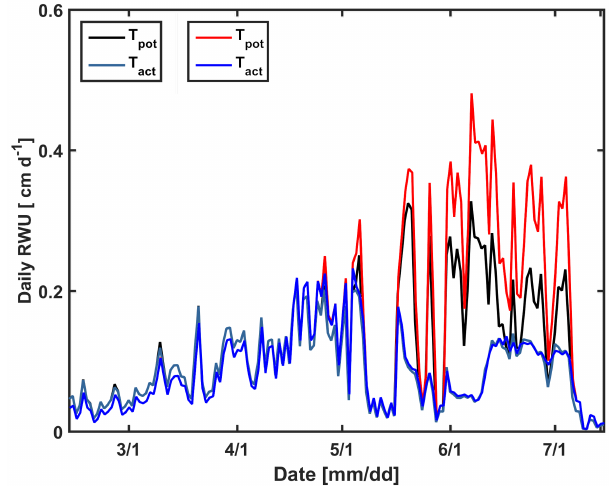
Figure 14. Daily potential ( T pot ) and actual transpiration ( T act = RWU) estimated by the Couvreur model using the measured leaf area index (LAI) in the sheltered plot (black and cyan) of the stony soil and the LAI in the irrigated plot of the stony soil (red and